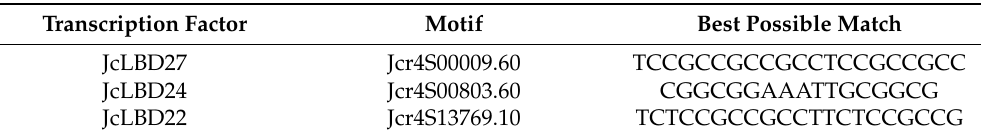
Table 1. Best possible binding sites for JcLBD s .